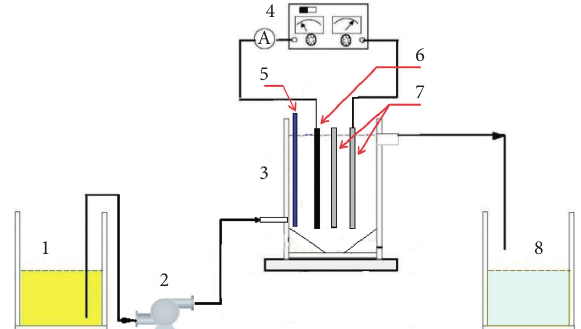
Figure 1: Schematic diagram of electro-Fenton experimental system: (1) feed tank, (2) pump, (3) EF reactor, (4) DC power supply, (5) feed air, (6) carbon-plated iron, (7) iron-plated tank, and (8) product